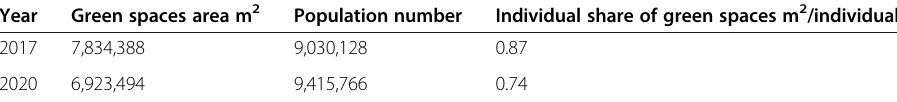
Table 2 Summary of green spaces data in the years 2017 and